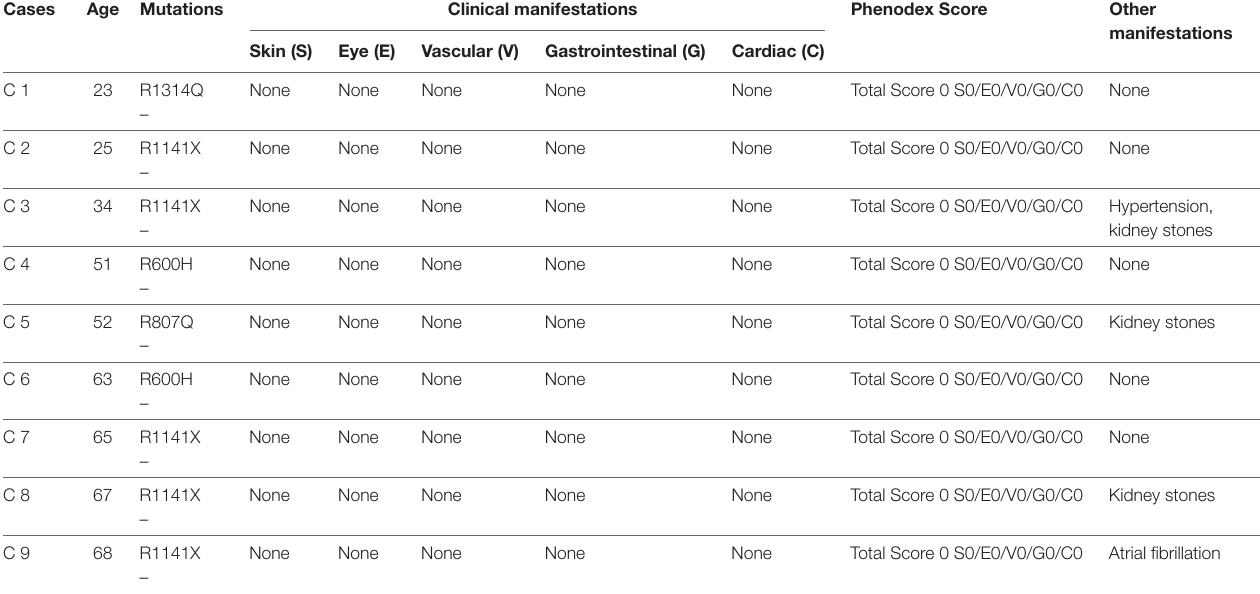
Table 3 | Clinical and molecular features in ABCC6 mutation carriers.